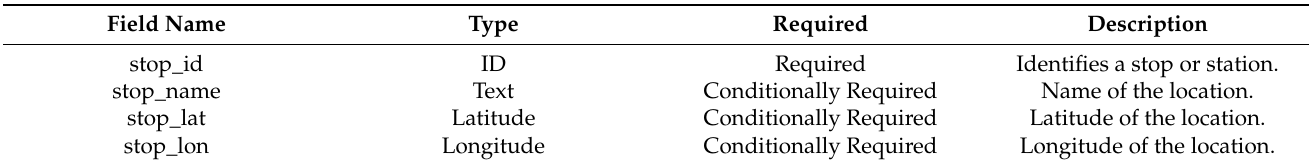
Table 2. Format and contents of the “stops” attributes table [57].